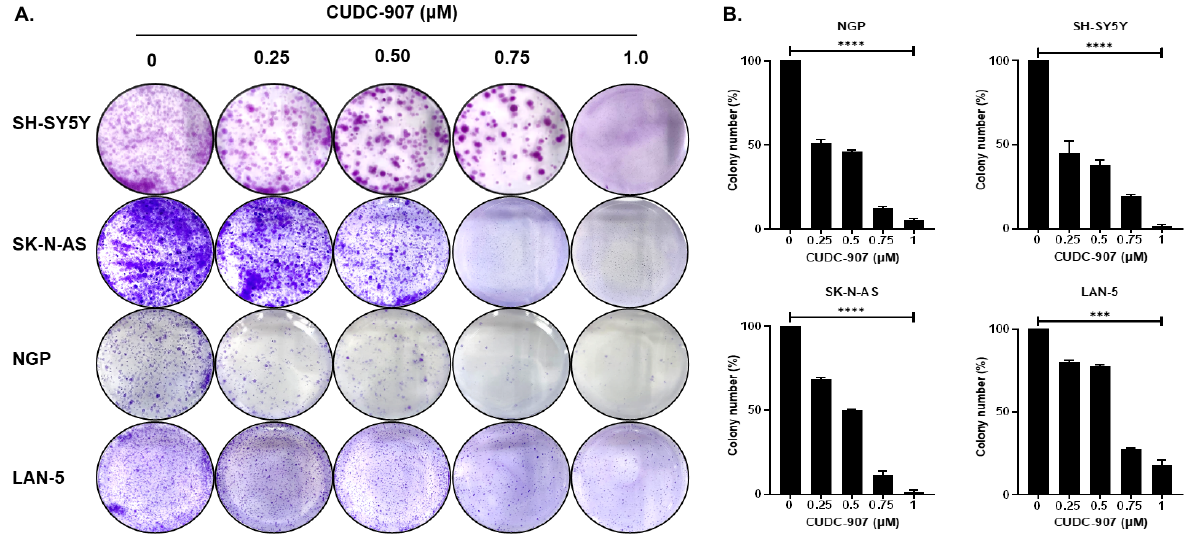
Figure 3. CUDC-907 inhibits NB colony formation and growth. Colony formation assays in response to CUDC-907 in four NB cell lines. ( A ) Representative images of colony formation assays in MYCN - amplified cell lines NGP and LAN-5, and MYCN non-amplified cell lines SH-SY-5Y and SK-N-AS in response to CUDC-907 treatment. Cells were treated with CUDC-907 for 48 h. ( B ) Survival index graphs showing the quantitation of the relative inhibition of colony formation in the respective cell lines in response to CUDC-907 treatment. Colony numbers are normalized to control. *p<0.05, *** p<0.001, **** p<0.0001.